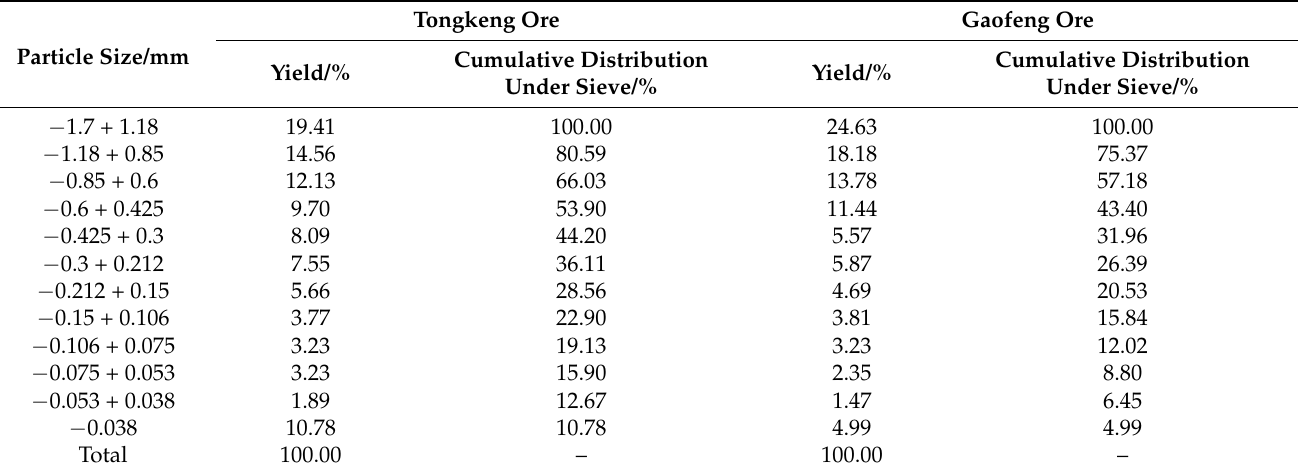
Table 3. Particle size distribution of two types of ores